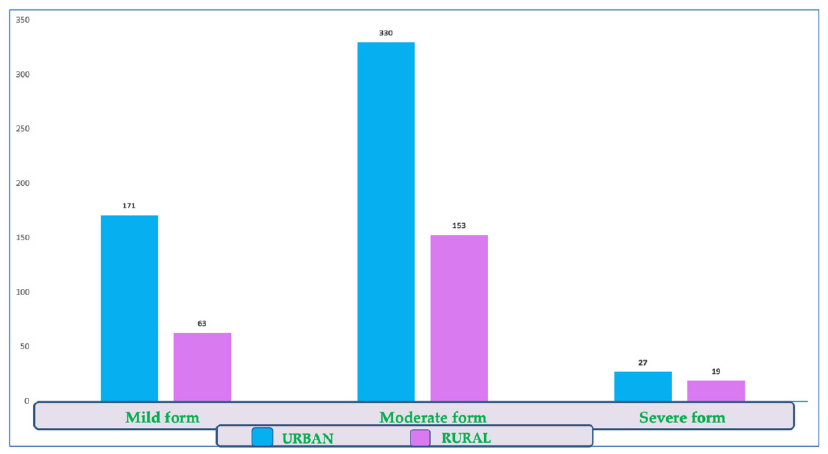
Figure 4. Distribution of COVID-19 disease forms by environmental background.